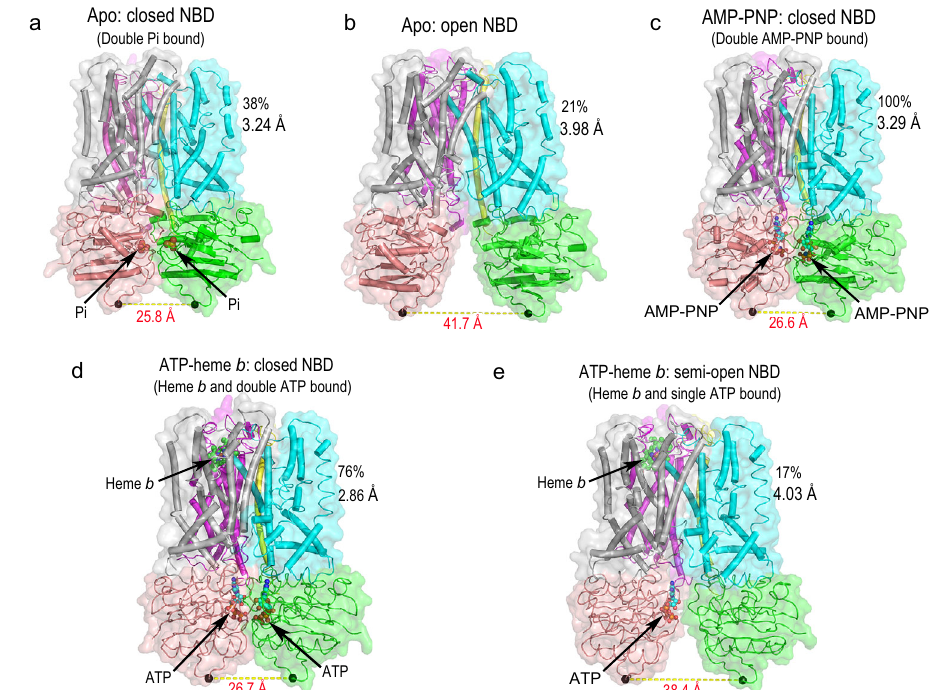
Fig. 3 | The CcmABCD complex undergoes conformational changes upon the binding of substrates. a Closed NBD conformation of CcmABCD bound with two phosphates. b Open NBD conformation of ligand-free CcmABCD. c Closed NBD conformation of CcmABCD bound with two AMP-PNPs. d Closed NBD